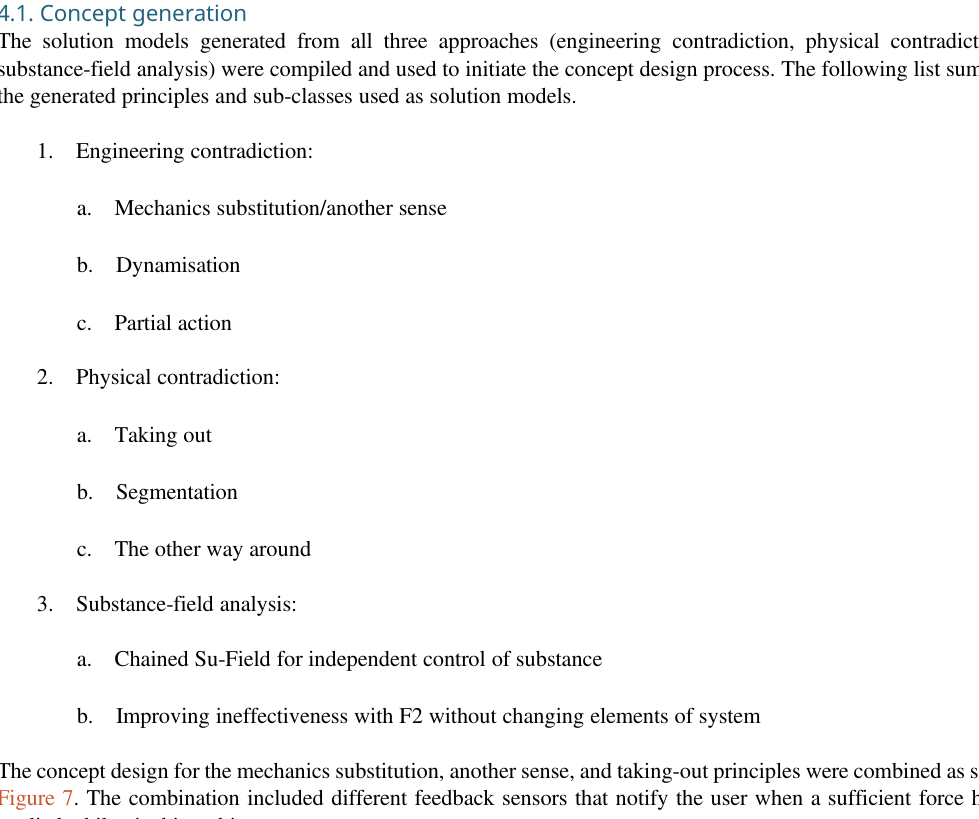
Figure 7. The combination included different feedback sensors that notify the user when a sufficient force has been applied while pinching objects.